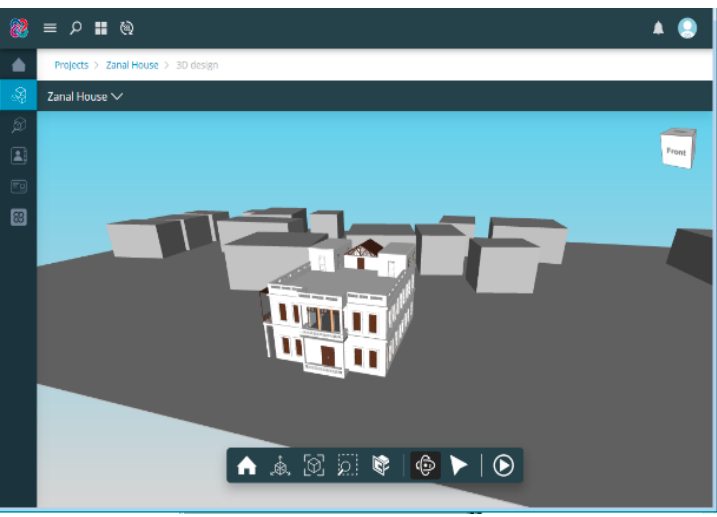
Figure 12. Inserting the model in the BIM server.center.